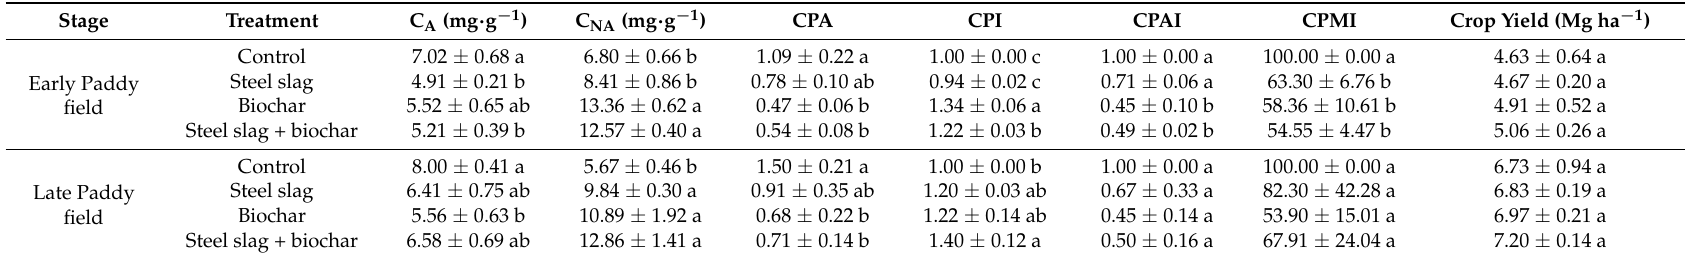
Table 2. Effects of waste amendment on the soil carbon pool management index and crop